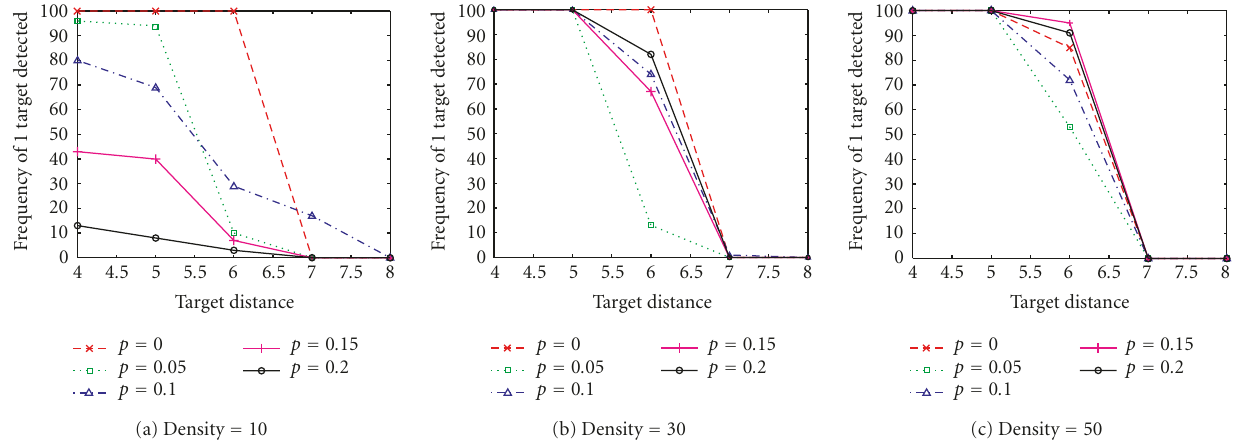
Figure 6: Frequency of one target detected versus target distance when two targets are deployed, T = 9, and density = 10,30,50, respectively.